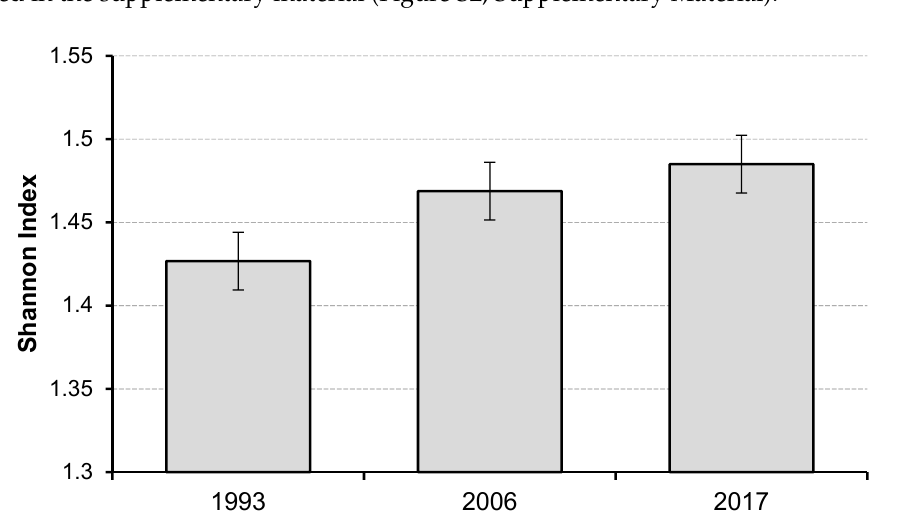
Figure 8. Change in mean values (and sample error) of Shannon species diversity SSP index over the 24-year period in the multispecies, uneven-aged forest.